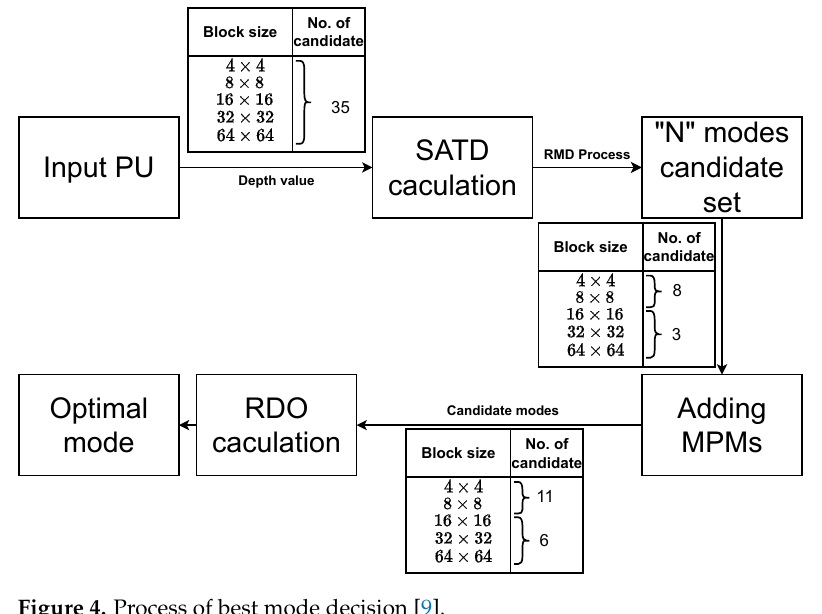
Figure 4. Process of best mode decision